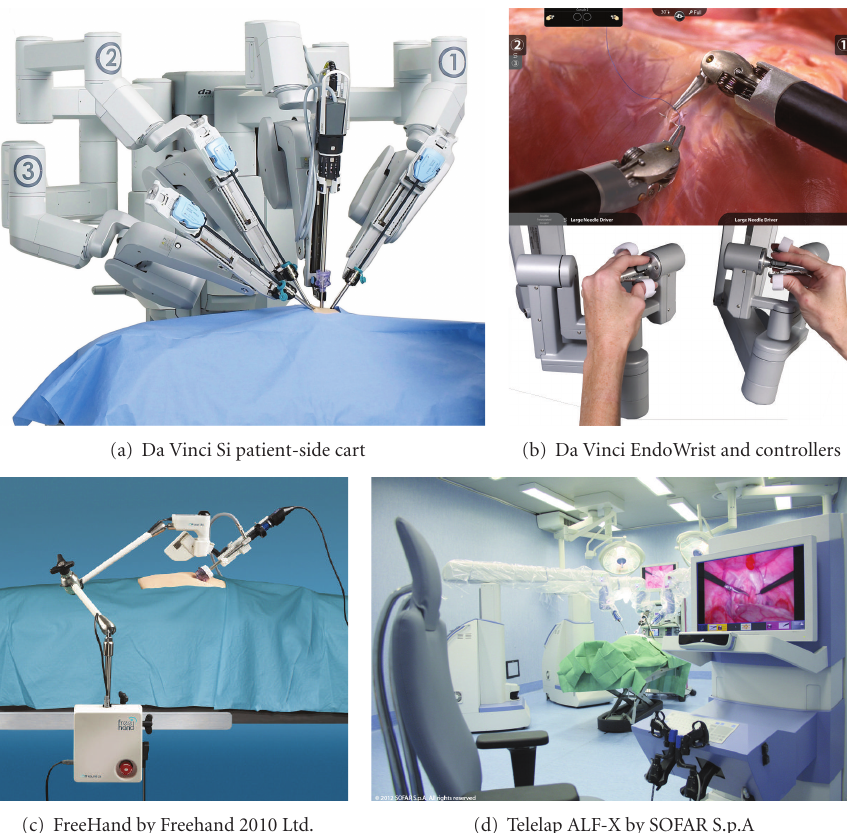
Figure 3: Laparoscopy robots. The da Vinci Si, by Intuitive Surgical Inc. (a) Cart and (b) image mosaic showing the tool tips with EndoWrist articulation, and the instrument controls. (c) FreeHand, a next-generation endoscope holder. (d) A computer model of the Telelap ALF-X, by SOFAR S.p.A. The da Vinci images are ©2012 Intuitive Surgical, Inc. The FreeHand image is ©2012 Freehand 2010 Ltd. The Telelap ALF-X image is ©2012 SOFAR S.p.A. All rights